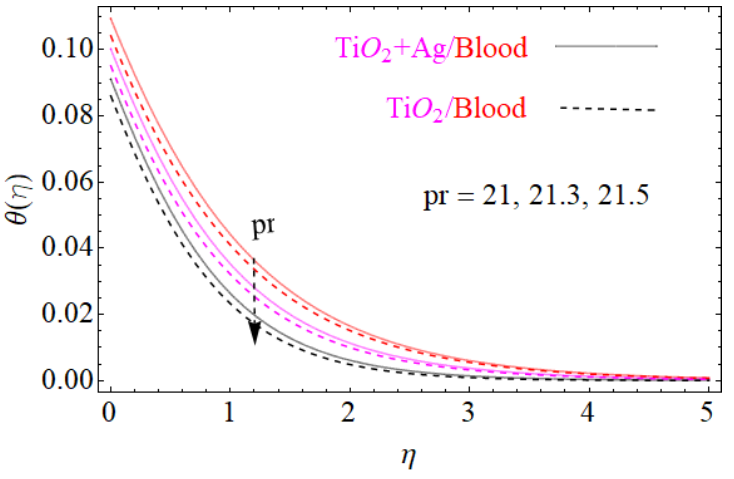
Figure 7. Effect of Prandtl number on temperature profile.